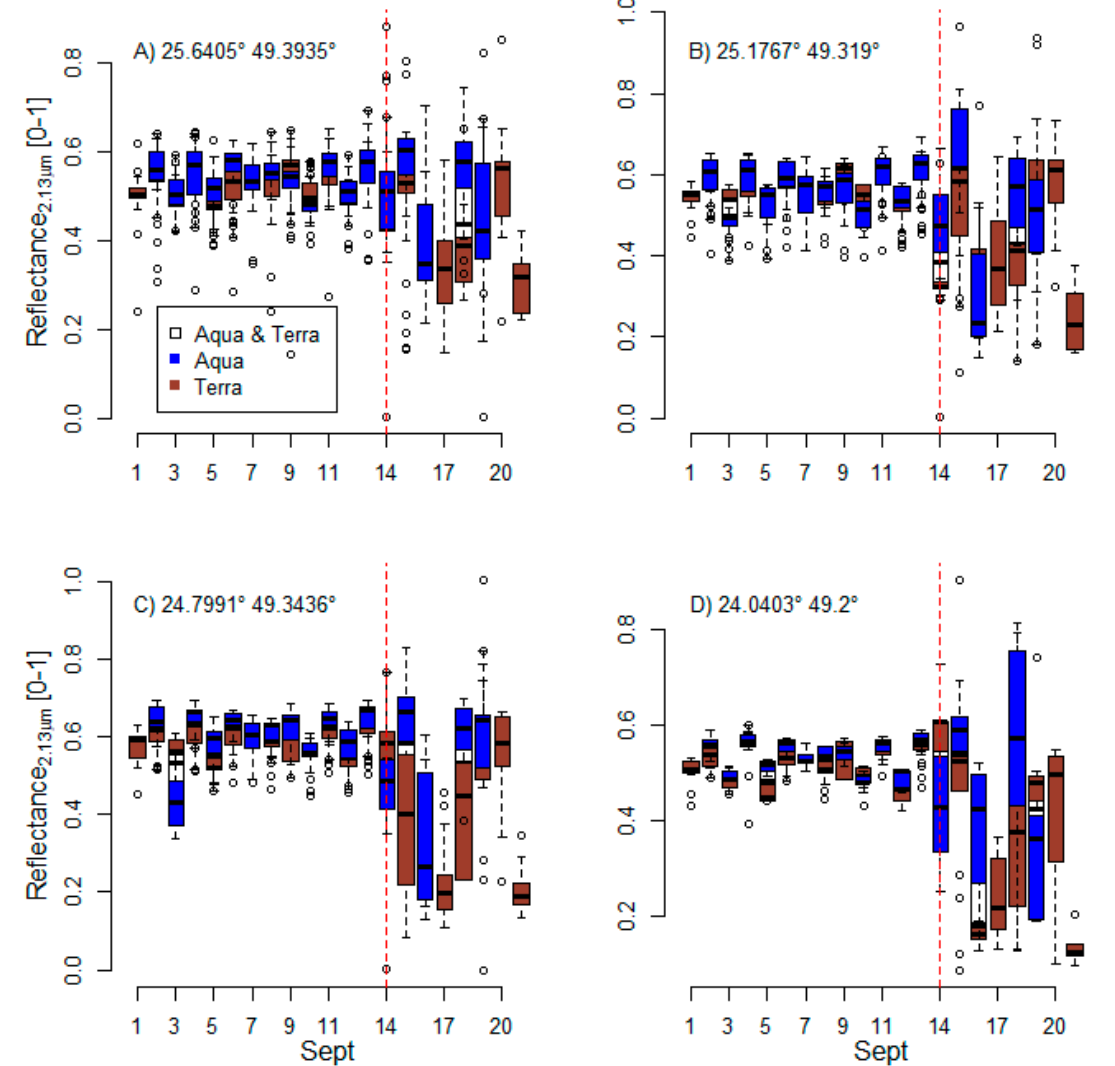
Figure 4. Time series of 2.13 µ m (MODIS band 7) reflectance from MODIS Terra (brown) and Aqua (blue) platforms summarized as whisker plots for the four ( A – D ) flares illustrated in each frame of Figure 1. Central geographic coordinates are shown for each flare site illustrated in Figure 1 is also shown in each frame. The mean is boxed by the 75th and 25th percentiles. The vertical red dashed line marks the day of emergency flaring. Di ff erent satellites with di ff erent overpass times have similar reflectance before the day of flaring, while they are di ff erent and mostly lower after the day of emergency flaring. Central geographic coordinates shown for each flare illustrated in Figure 1 are also shown in each frame.